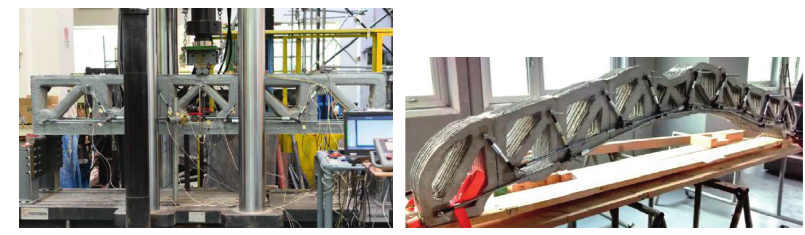
Figure 10: RC beams composed from printed segments connected externally with steel